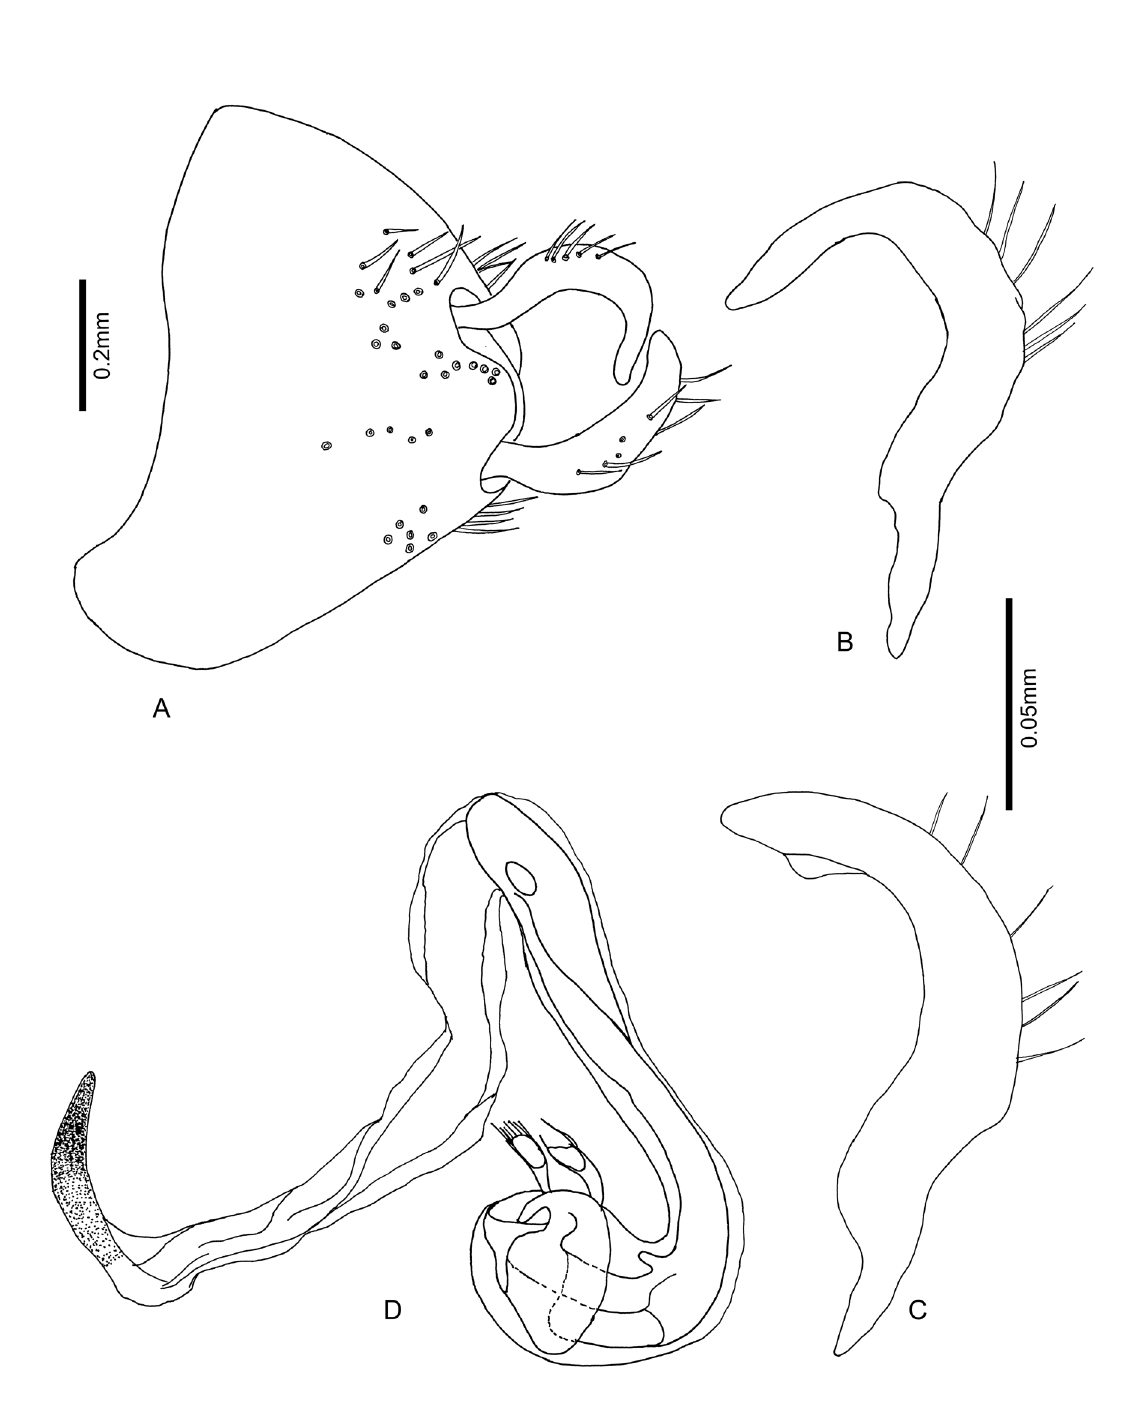
Fig. 22. Male genitalia of Namyatovia sirsiensis gen. et sp. nov., holotype, UASB. A . Genital capsule in ventral view. B . Left paramere in dorsal view. C . Right paramere in dorsal view. D . Aedeagus in lateral